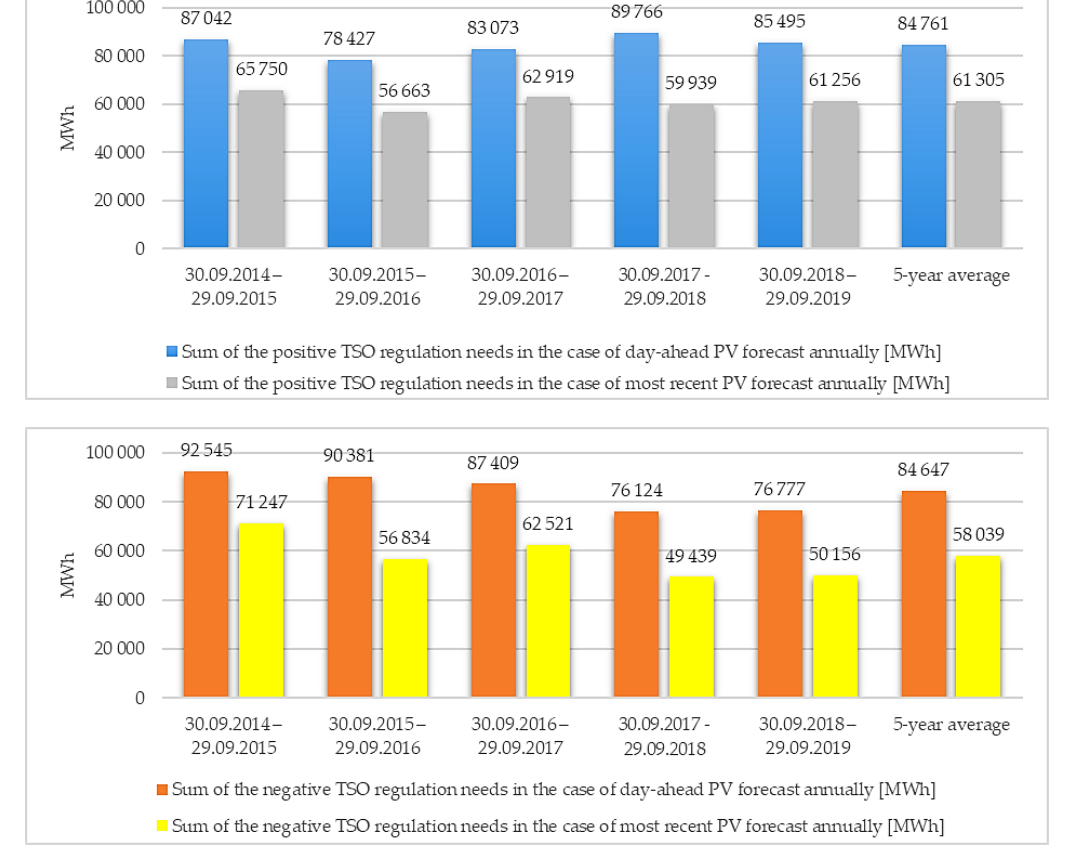
Figure 7. The summarized results of the positive and negative TSO regulation needs based on the day-ahead and most recent PV energy forecasts in the case of a 1000 MWp PV system for the period of 30 / 09 / 2014–30 / 09 /